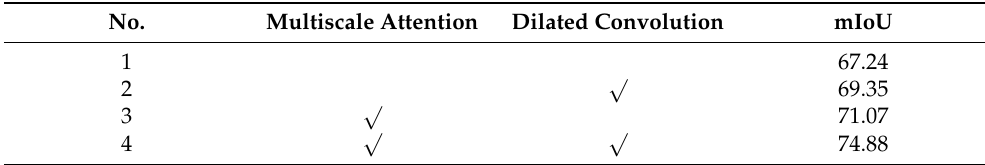
Figure 8 . Some examples of results obtained by Model 2 with input image; ( b ) prediction result; ( c ) composited image. input image; ( b ) prediction result; ( c ) composited image. Table 7. Performance analysis on the test dataset of